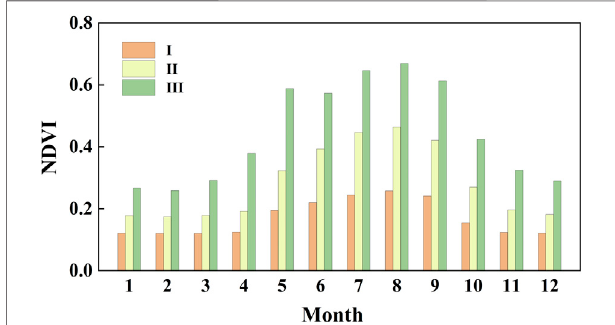
FIGURE 8 | Intra-annual variation of NDVI in different climatic zones of the Yellow River